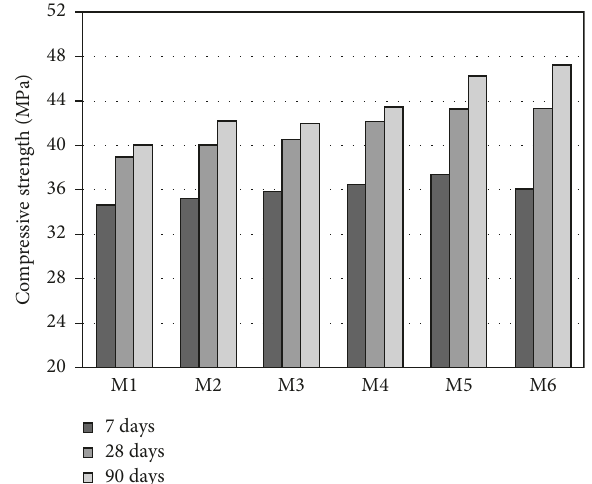
Figure 6: Compressive strength gains of different types of concrete made with sulfonated naphthalene polymer-based SP1 with respect to age.